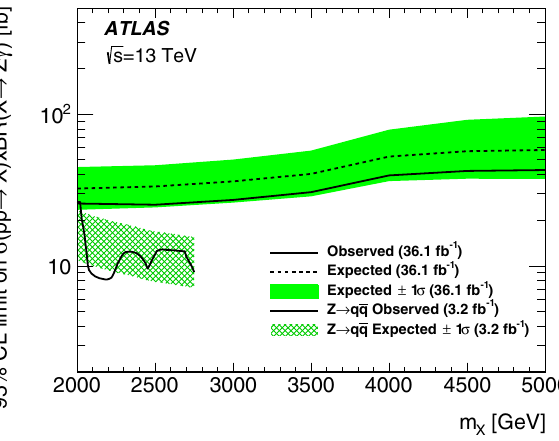
Fig. 7 The observed (expected) limit at 95% CL on the production cross section of a Z γ resonance as a function of its mass. The limits from the search in the Z → q ¯ q channel with 3.2 fb − 1 [84] are also